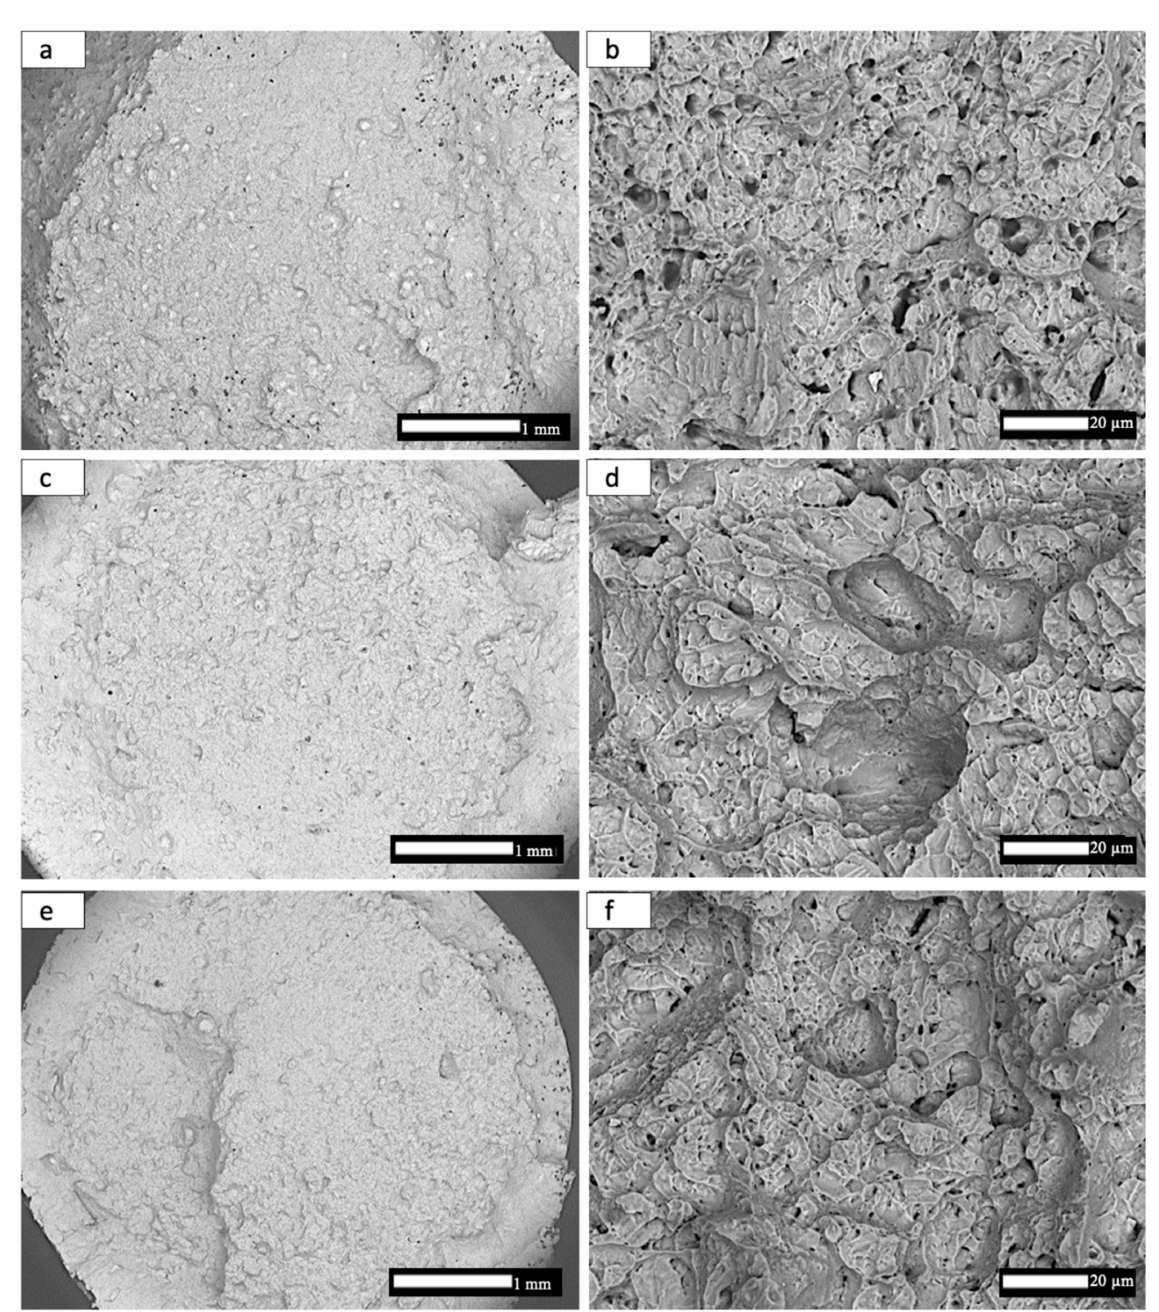
Figure 12. SEM images of fracture surfaces. ( a , b ) show low and high magnification of the Anneal fracture. ( c , d ) show low and high magnification of the HIP fracture. ( e , f ) show low and high magnification of the HIP + Anneal